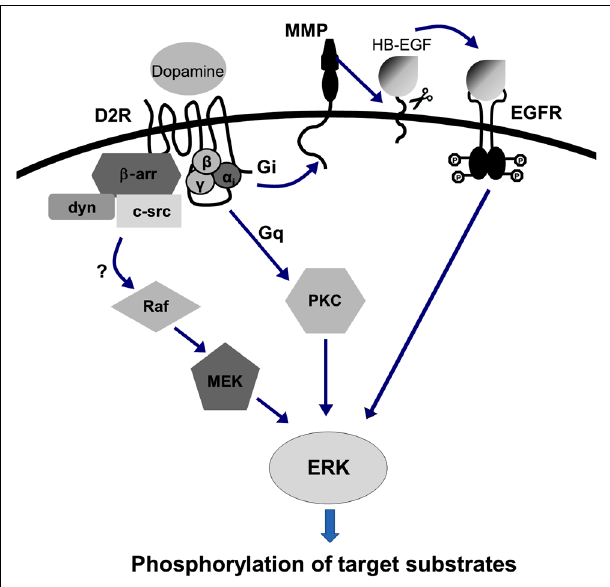
FIGURE 2 | D2 receptor-mediated ERK activation signaling pathway. D2 receptor-mediated ERK activation is dependent on G α i protein coupling. It also appears that D2 receptor-mediated ERK activation requires the transactivation of receptor tyrosine kinase, which consequently activates downstream signaling involving matrix metalloproteinases (MMPs) with ectodomain shedding of EGFR ligand, for example, to finally activate ERK (Choi etal., 1999; Kim etal., 2004;Wang etal., 2005;Yoon etal., 2011;Yoon and Baik, 2013).The involvement of arrestin has also been suggested to contribute to D2 receptor-mediated ERK activation (Beom etal., 2004; Kim etal., 2004), which can activate MAPK signaling by mobilizing clathrin- mediated endocytosis in a β -arrestin/dynamin-dependent manner (Kim etal., 2004).